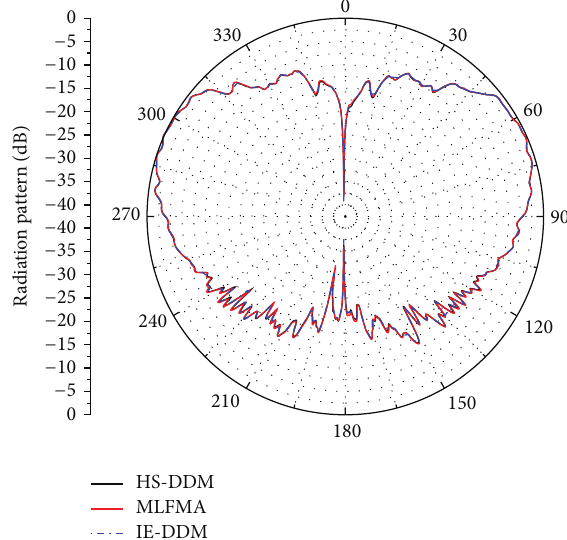
Figure 11: The normalized radiation pattern of the monopole antenna on helicopter at 1.0